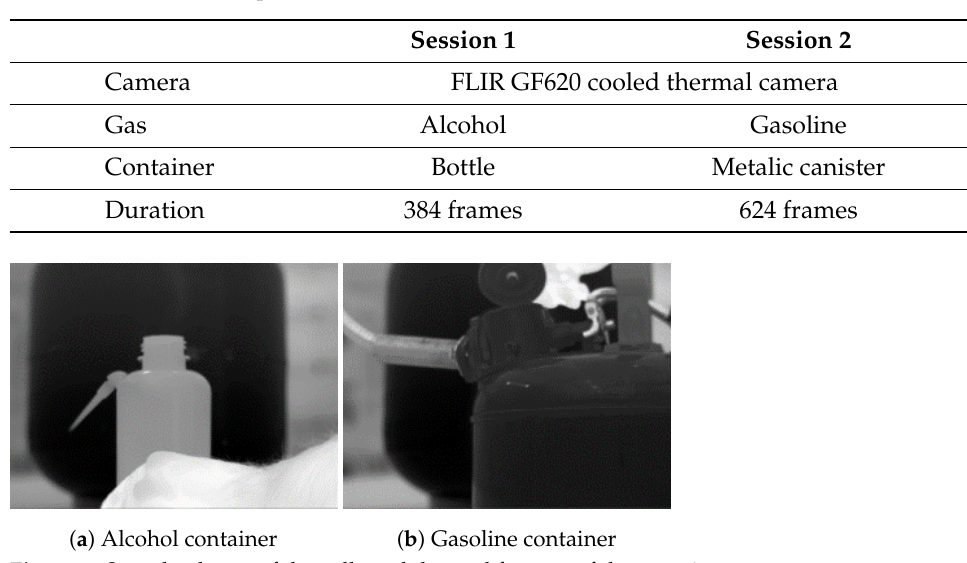
Figure 3. Sample photos of the collected thermal footage of the